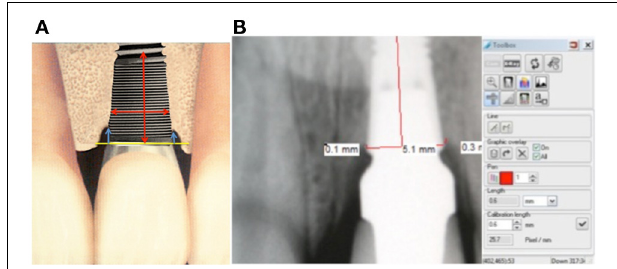
FIGURE 1 | Measurement technique. (A) Mesial and distal marginal bone loss calculated as vertical distance between crestal bone level and implant neck; (B) Software calculation of the MBL.